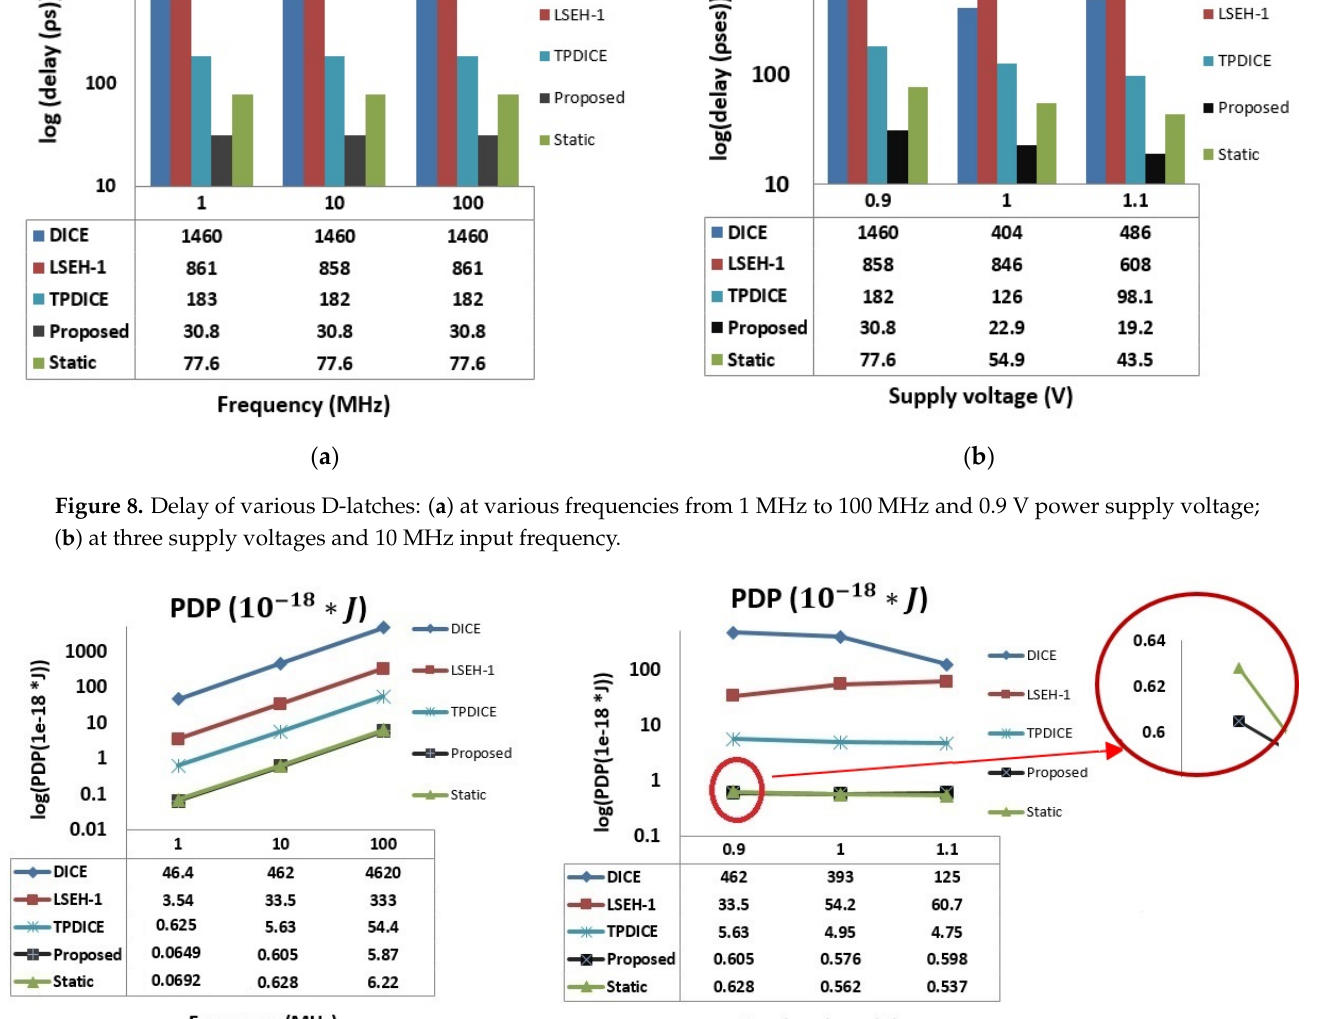
( b ) Figure 7. Power consumption of various D-latches: ( a ) at three frequencies from 1 MHz to 100 MHz and 0.9 V power supply voltage; ( b ) at three supply voltages and 10 MHz input frequency.